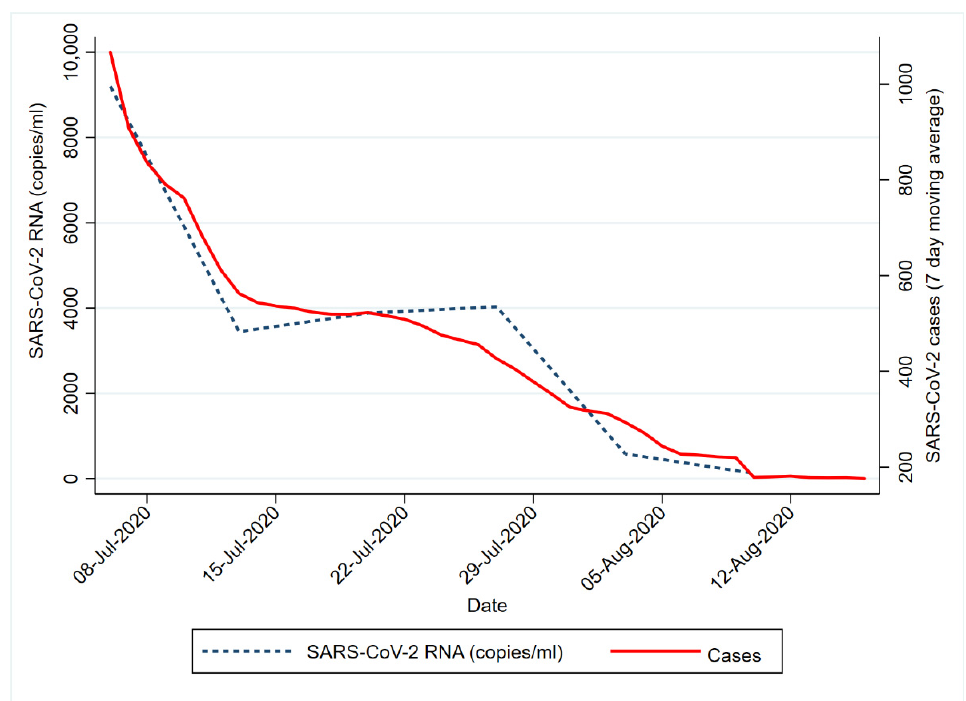
Figure 2. Number of confirmed new COVID-19 cases in the City of Cape Town from the period of 6 July 2020 to 10 August 2020. Data retrieved from the COVID-19 Dashboard from the Western Cape Provincial Government [6].